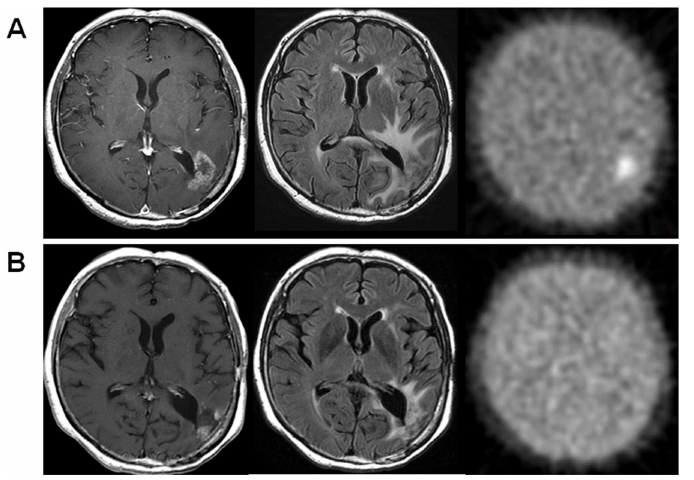
Fig 5. Representative cases of MRI-FMISO double responder (Case 10). The panel compositionis same as Fig 4. After BEV treatment, contrast-enhancedlesionand FLAIR hyperintensity lesionswere decreased. Simultaneously, FMISO accumulation was